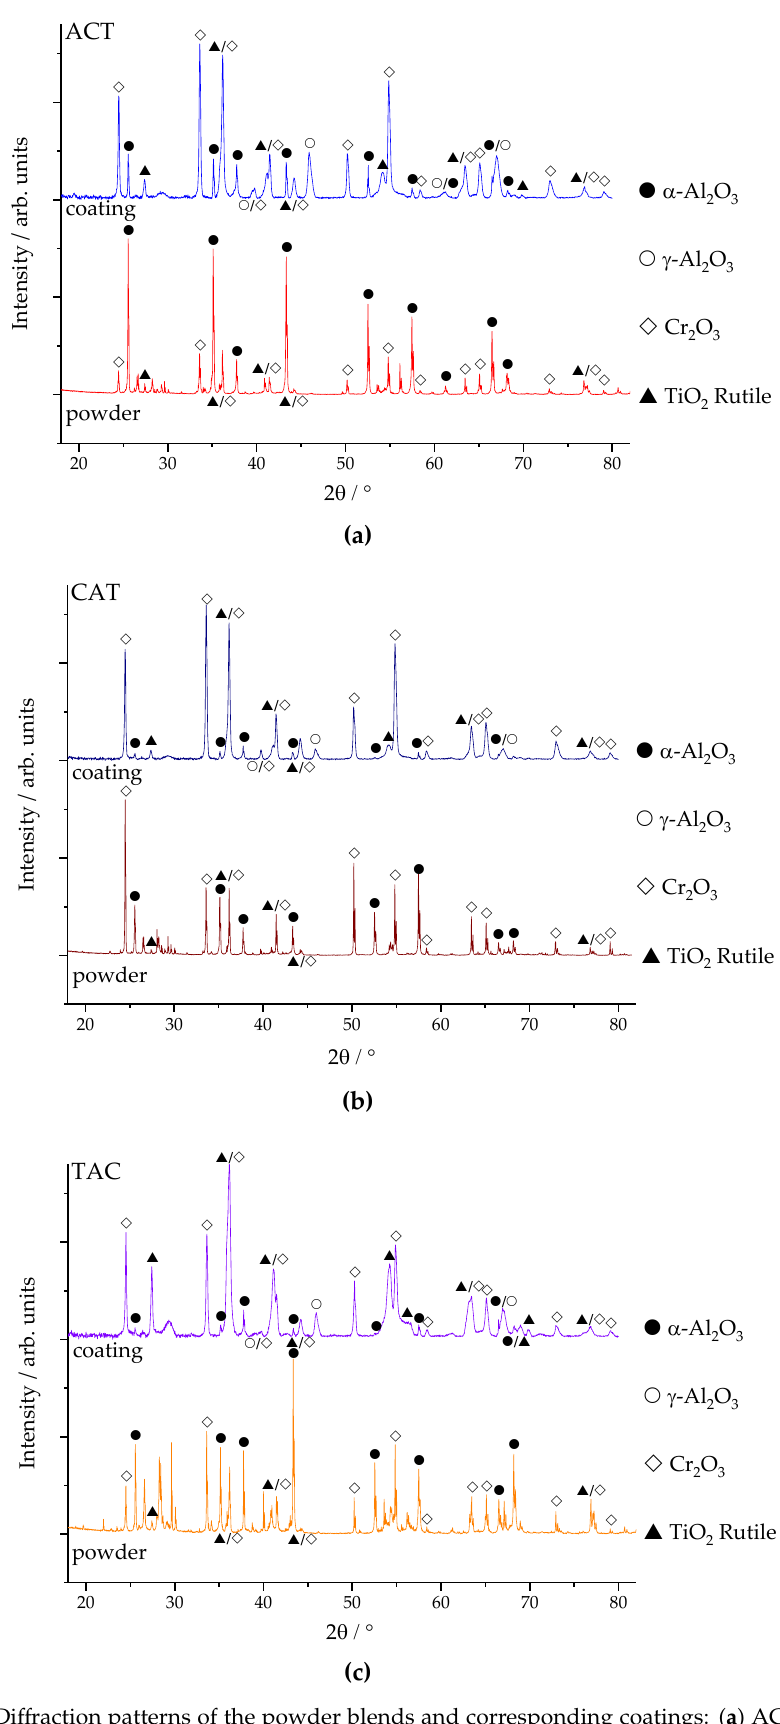
Figure 8. Diffraction patterns of the powder blends and corresponding coatings: ( a ) ACT, ( b ) CAT, and ( c ) TAC.